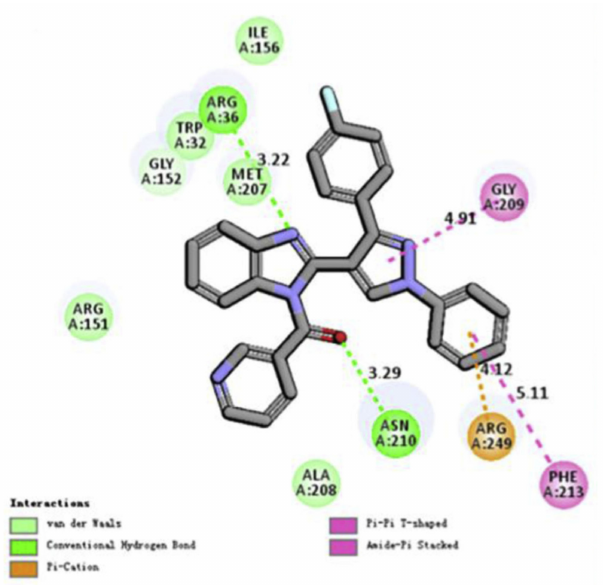
Figure 2. Docking model of representative compound 67 . 2D molecular docking modeling of compound 67 and surrounding residues of E. coli FabH (PDB code: 1HNJ) adapted from